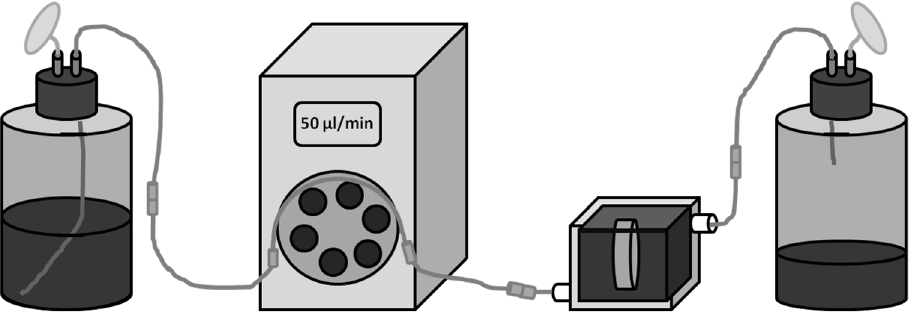
Figure 4. Test system. From left to right: Cooled medium reservoir with air filter, ISMATEC peristaltic pump, reactor with scaffold, waste container. Connections via gas permeable silicon tubes and luer-lock pins.